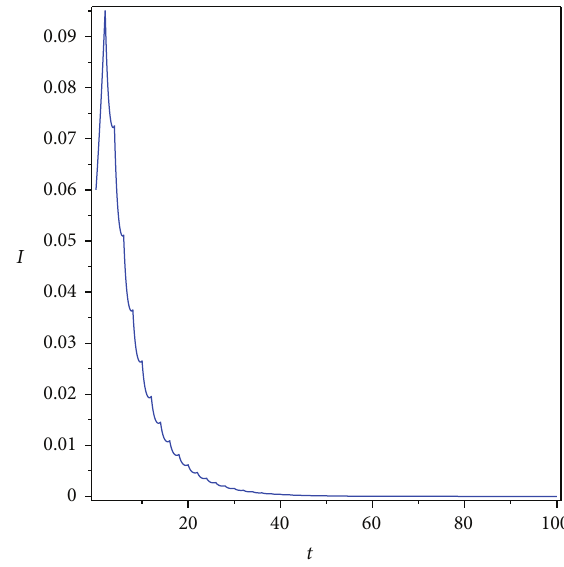
Figure 3: Time series of 𝐼 of system (42) while 𝜃 = 0